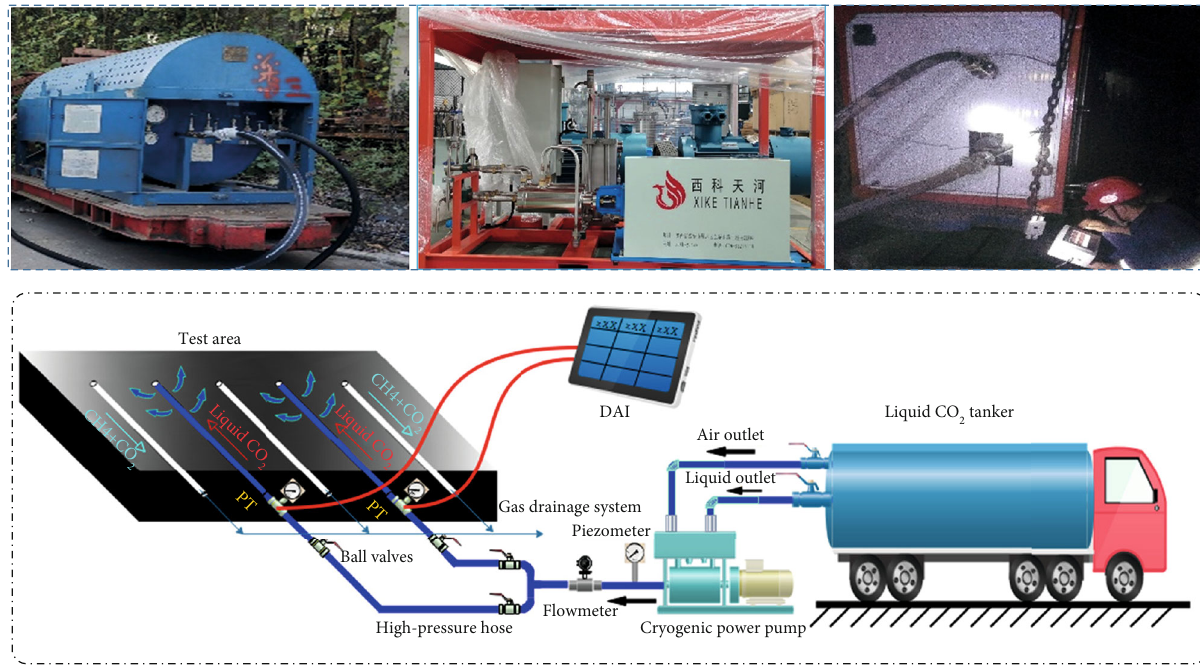
Figure 3: Process diagram of liquid CO